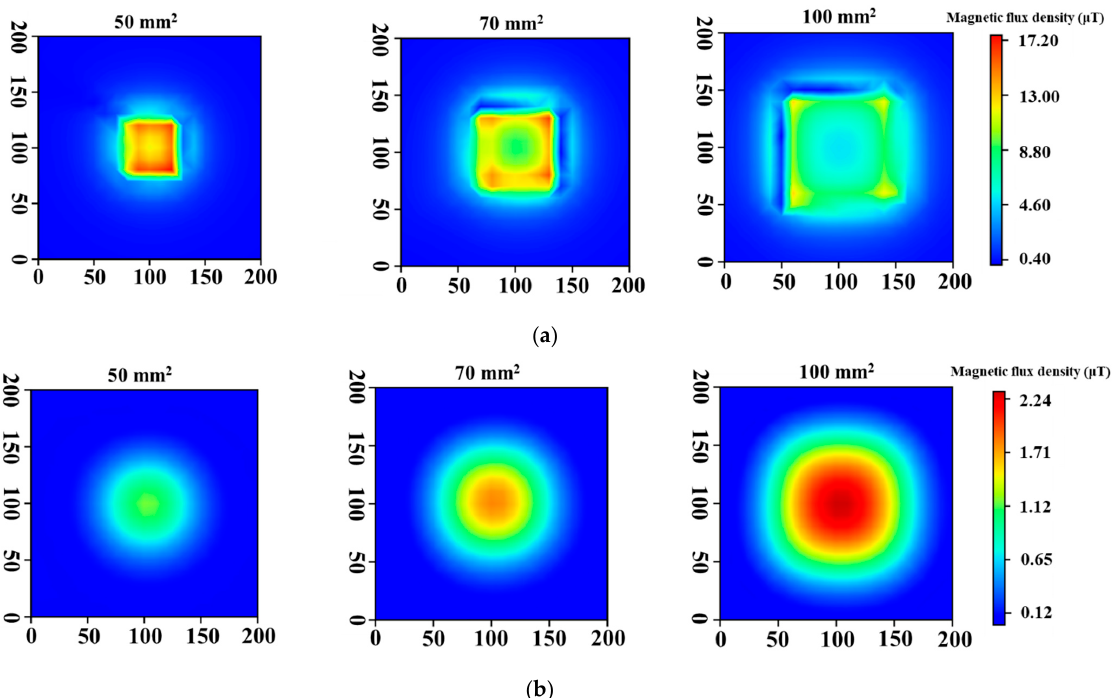
Figure 6. Magnetic field distributions with prototyped probes at lift-offs: ( a ) 0 mm and ( b ) 50 mm.